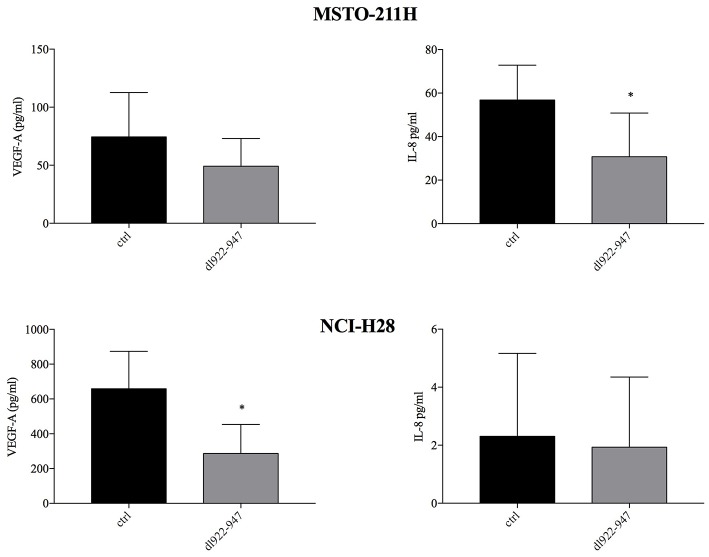
Effect of dl922-947 on VEGF-A and IL-8 production by MPM cells. MSTO-211H and NCI-H28 cells were infected with dl922-947 at the IC50. VEGF-A and IL-8 secretion was assessed by ELISA 48 hpi. The histograms represent the mean of six independent experiments ± s.d. The statistical analysis was performed by Mann-Whitney test (*p < 0.05).